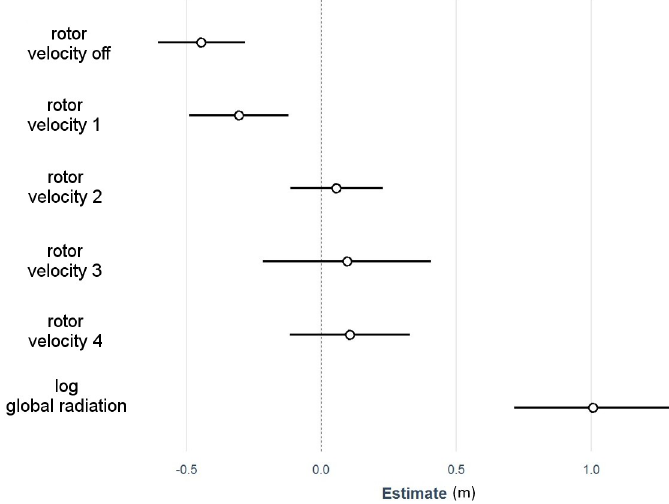
Fig 3. Results of the linear mixed model assessing the minimum distance to the rotor dependent on the operational state of the SWT and the global radiation. The monitoring site served as a random factor. Circles indicate regression coefficients, and lines the 95% confidence intervals. The telescope pole (dotted line) was set up as a reference.